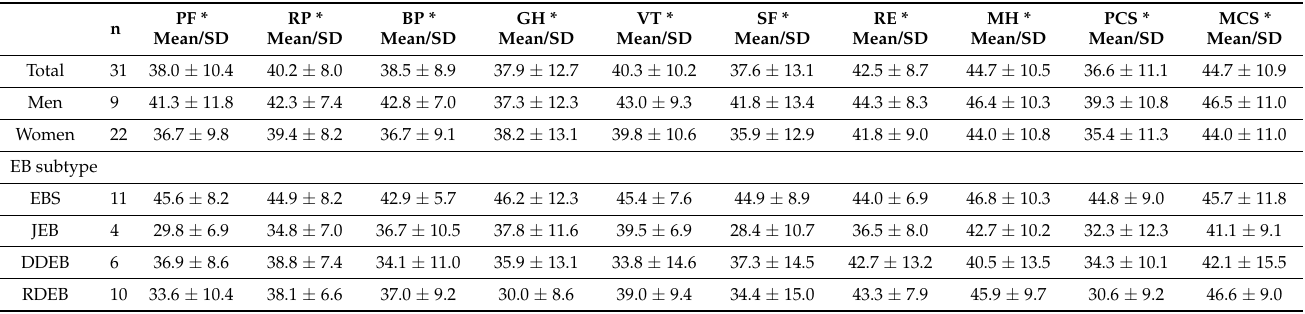
Table 5. SF 36 questionnaire values, by sex and EB